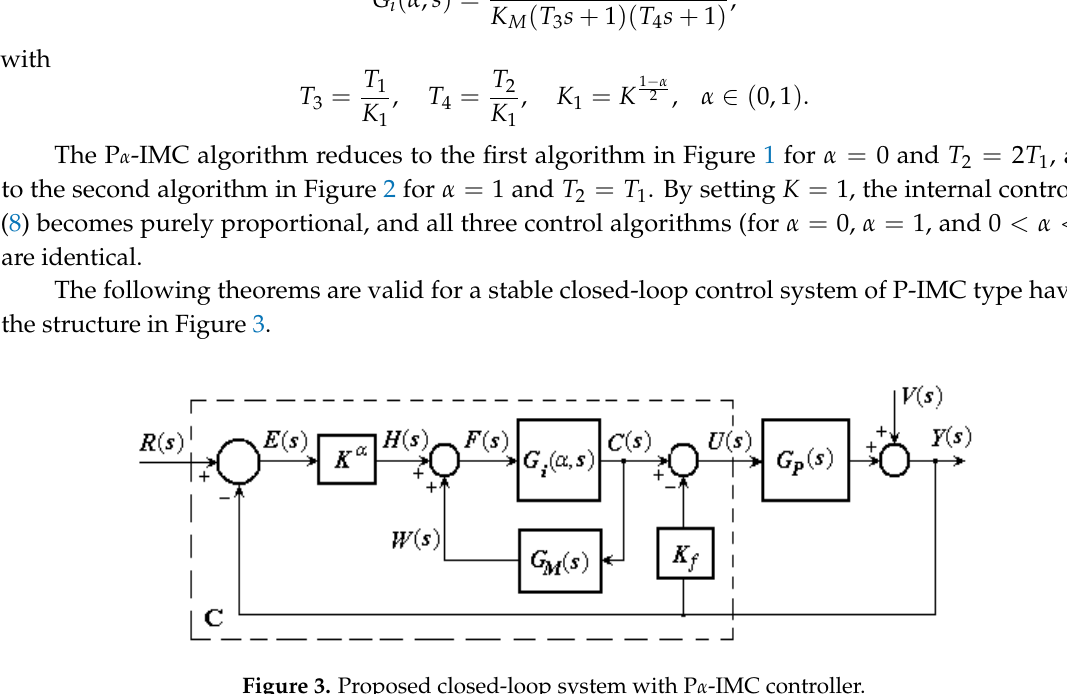
Figure 3. Proposed closed-loop system with P α -IMC